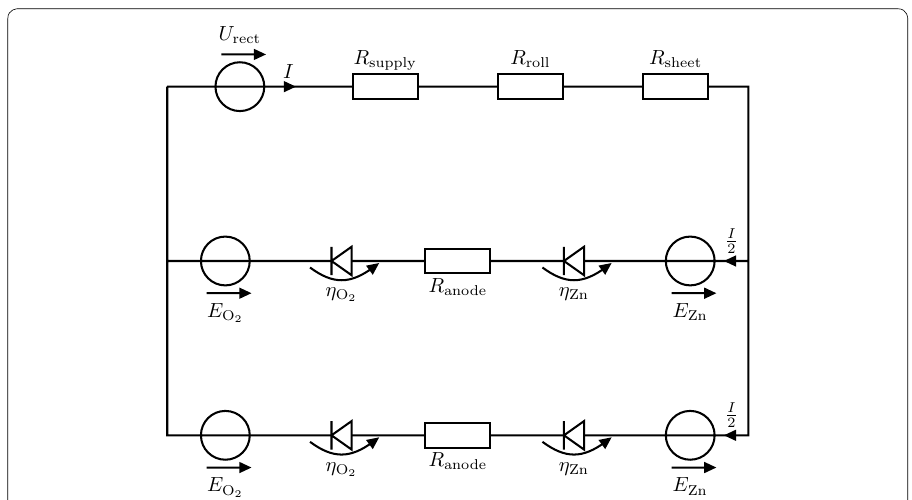
Fig. 4 Equivalent circuit of the electroplating